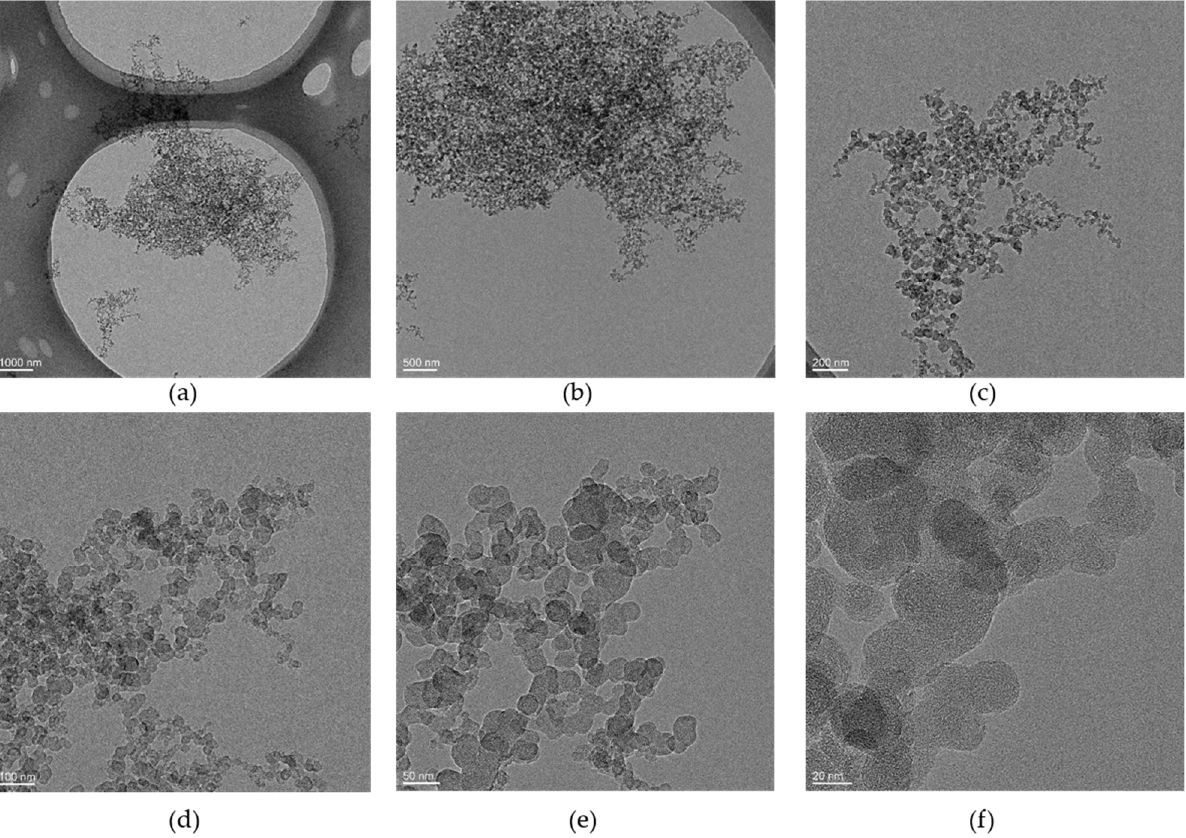
Figure 1. TEM images of the GDI PM. ( a ) 1000 nm; ( b ) 500 nm; ( c ) 200 nm; ( d ) 100 nm; ( e ) 50 nm; ( f ) 20 nm.